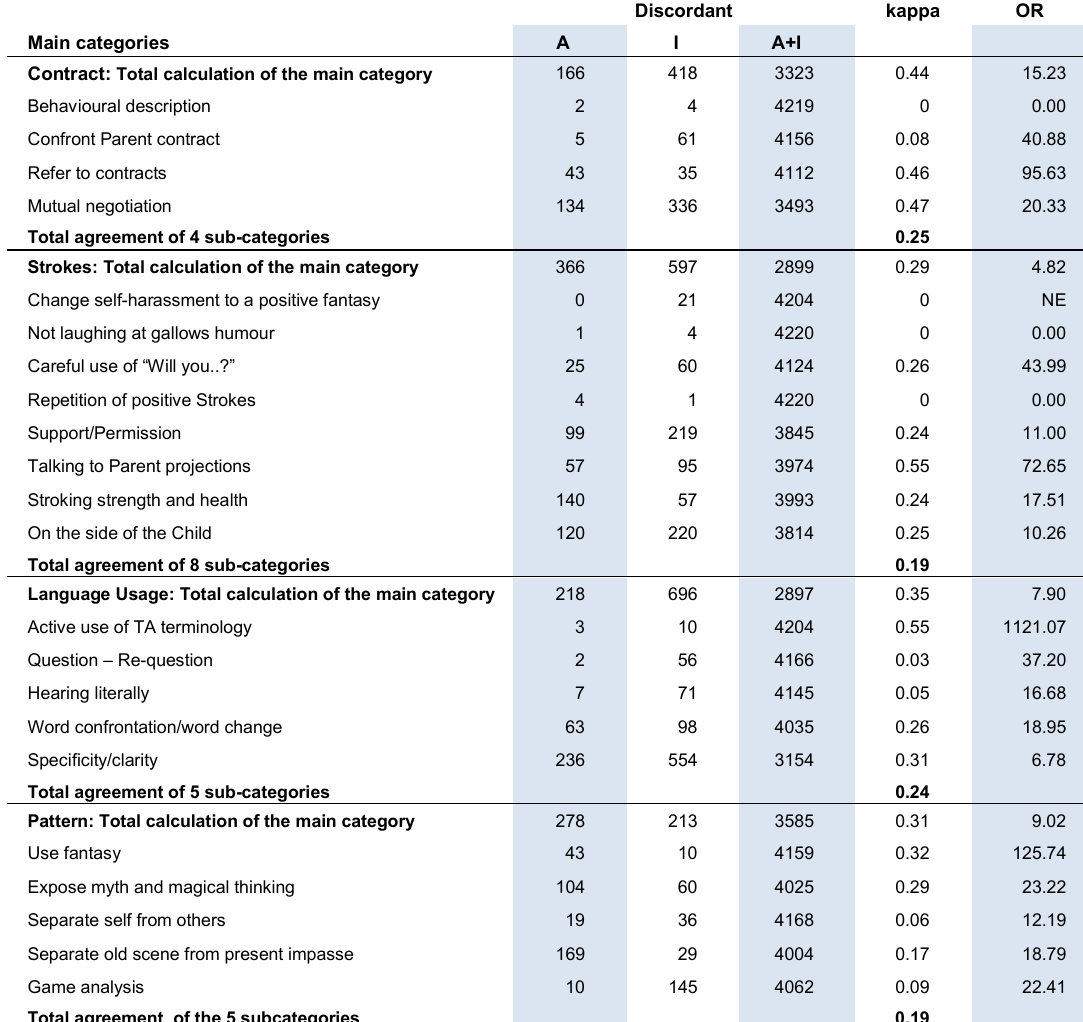
Table 8a: Calculation of kappa quotient (k) and OR quotients (OR) for 4 main and 22 sub-categories